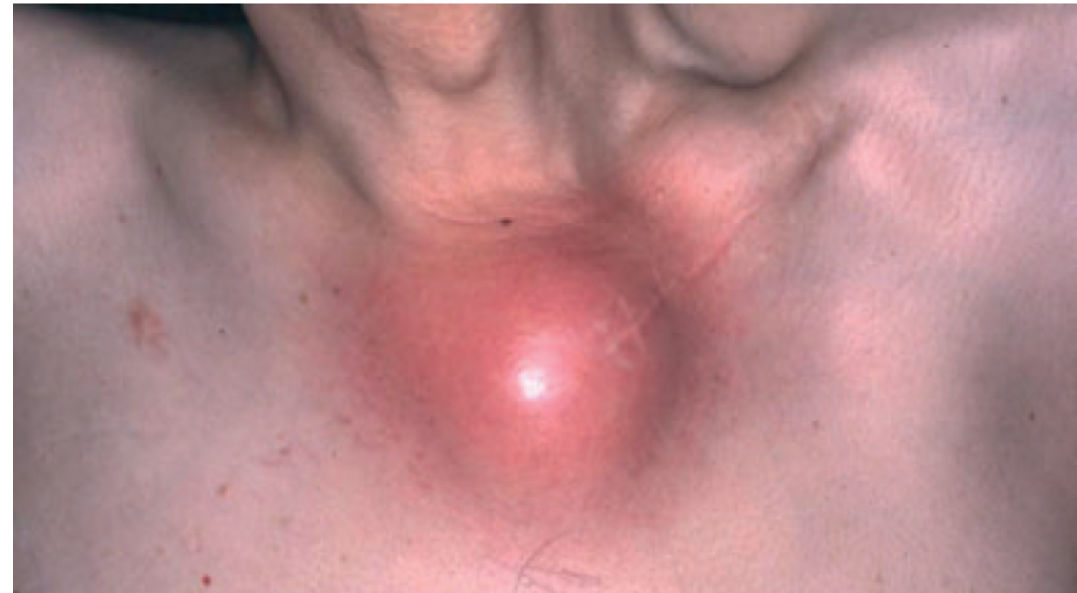
Figure 5. SAPHO syndrome showing involvement of the left sternocostoclavicular area with inflammation and swelling. Reproduced from Chen et al. [87] with permission from Wiley, Hoboken, NJ, USA.